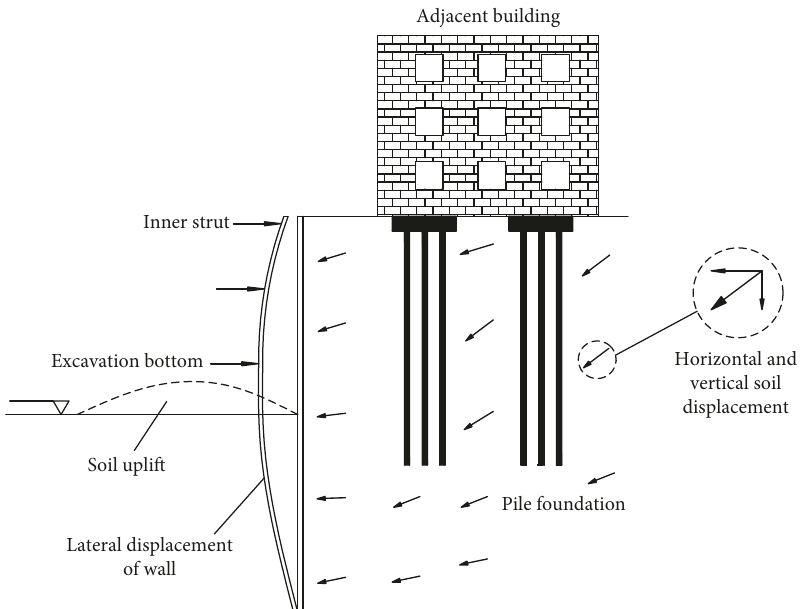
Figure 1: Displacement field around existing pile induced by